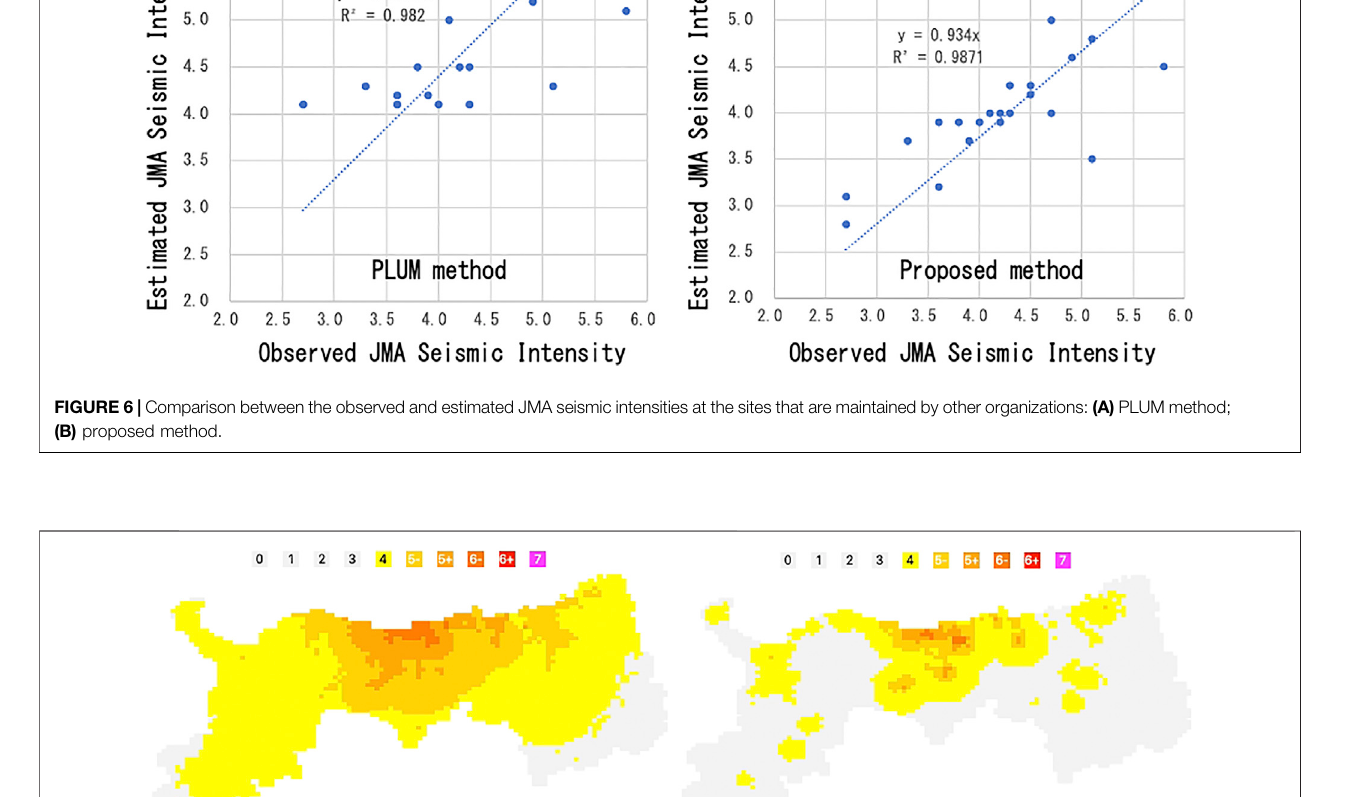
in the bottom panel with a radius of 16 km ( V 0 T ). The timestamp in the bottom panel indicates 40 s, but it was saturated at 14:07:33 in reality. The right column shows the result by the proposed method.